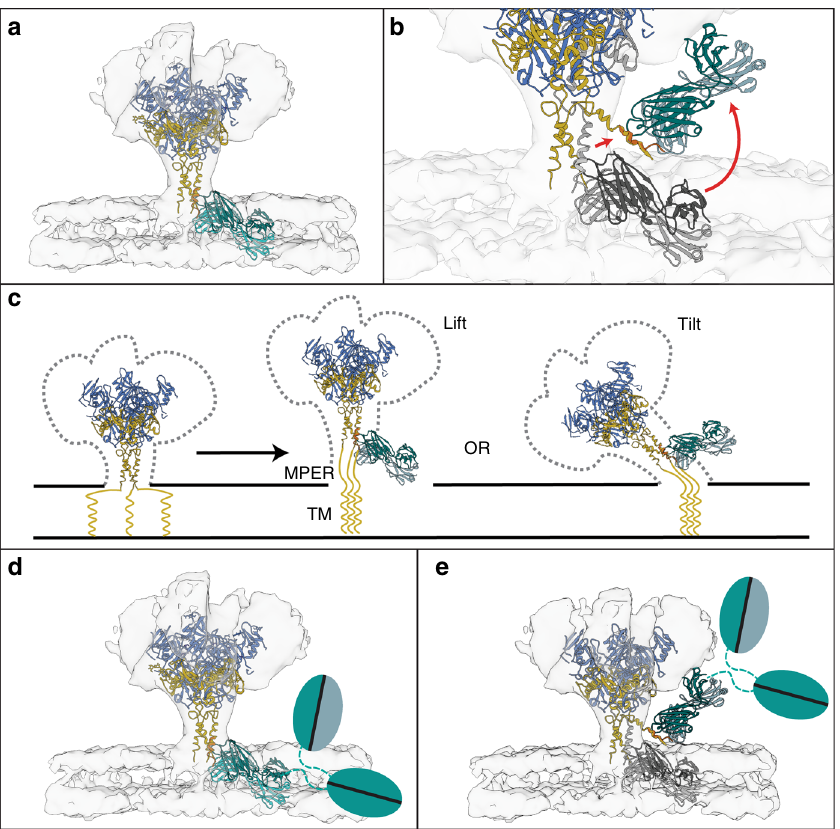
Fig. 4 Necessary displacement of the stalk to achieve binding of BDBV223. a When the BDBV223-GP peptide complex structure is aligned to the CryoEM structure of membrane-anchored EBOV GP [EMD-8630] 20 and the stalk-containing crystal structure of unbound EBOV GP [PDB: 5JQ7] 16, 20 , it is clear that the angle of approach of the BDBV223 Fab would clash with the expected position of the plasma membrane. b , c This steric hindrance indicates that the stalk regions of the GP may be ( b ) splayed from center upon antibody binding (gray to colored), or ( c ) lifted from membrane/tilted in order to expose the binding site. d , e Steric interference would be greater for the intact IgG of the wild-type antibody in either the unaltered ( d ) or splayed ( e ) conformation. Color Scheme: